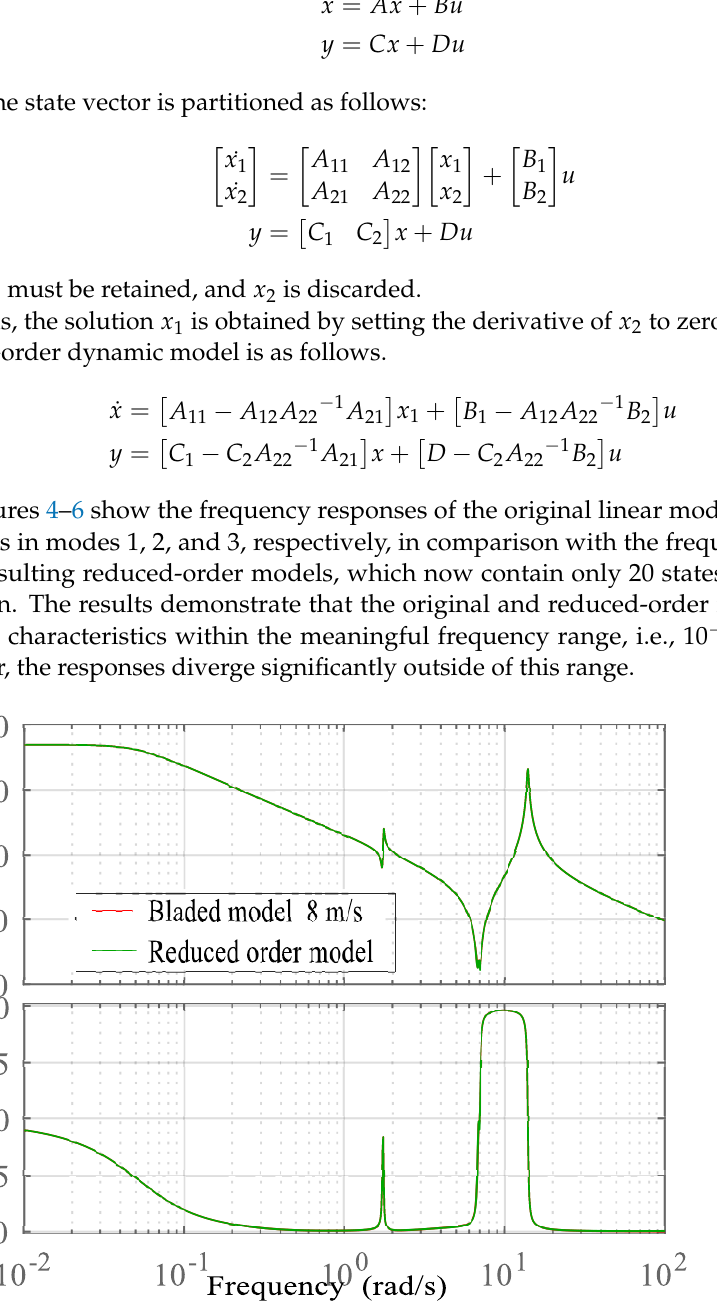
Figure 4. Frequency response of Bladed and reduced–order models in mode